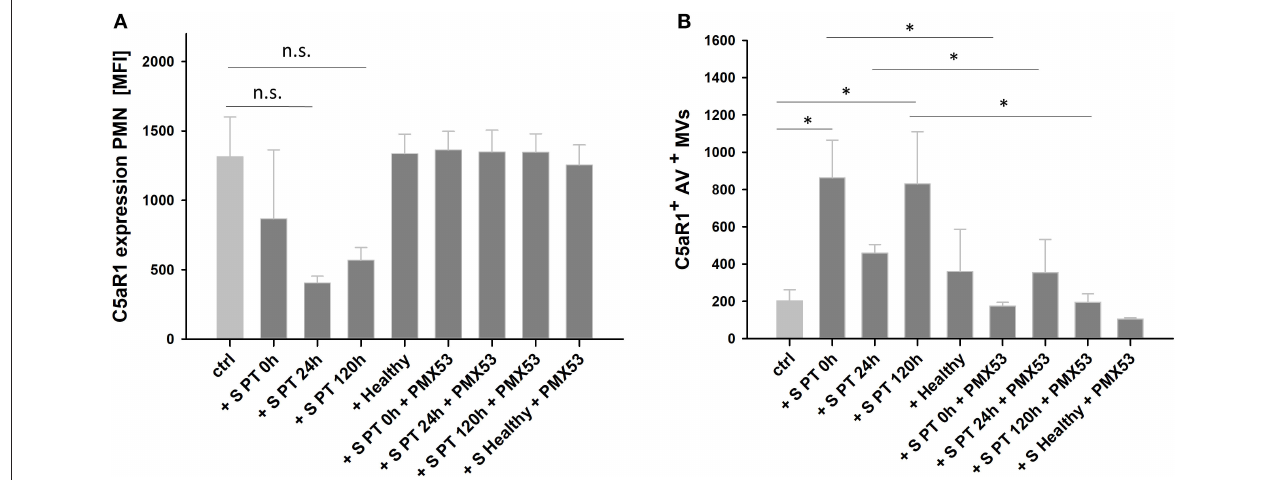
FIGURE 6 | C5aR1 expression and MV shedding after incubation of PMNs with serum obtained from PT patients (S PT) and healthy donors (S Healthy). PMNs were incubated in HBSS ++ buffer supplemented with 20% of pooled human serum from PT patients or from healthy donors for 1h. (A) Quantification of C5aR1 expression on PMNs and (B) C5aR1 + MV counts in 10 µ l of PMN supernatants after incubation. n = 4, * p <